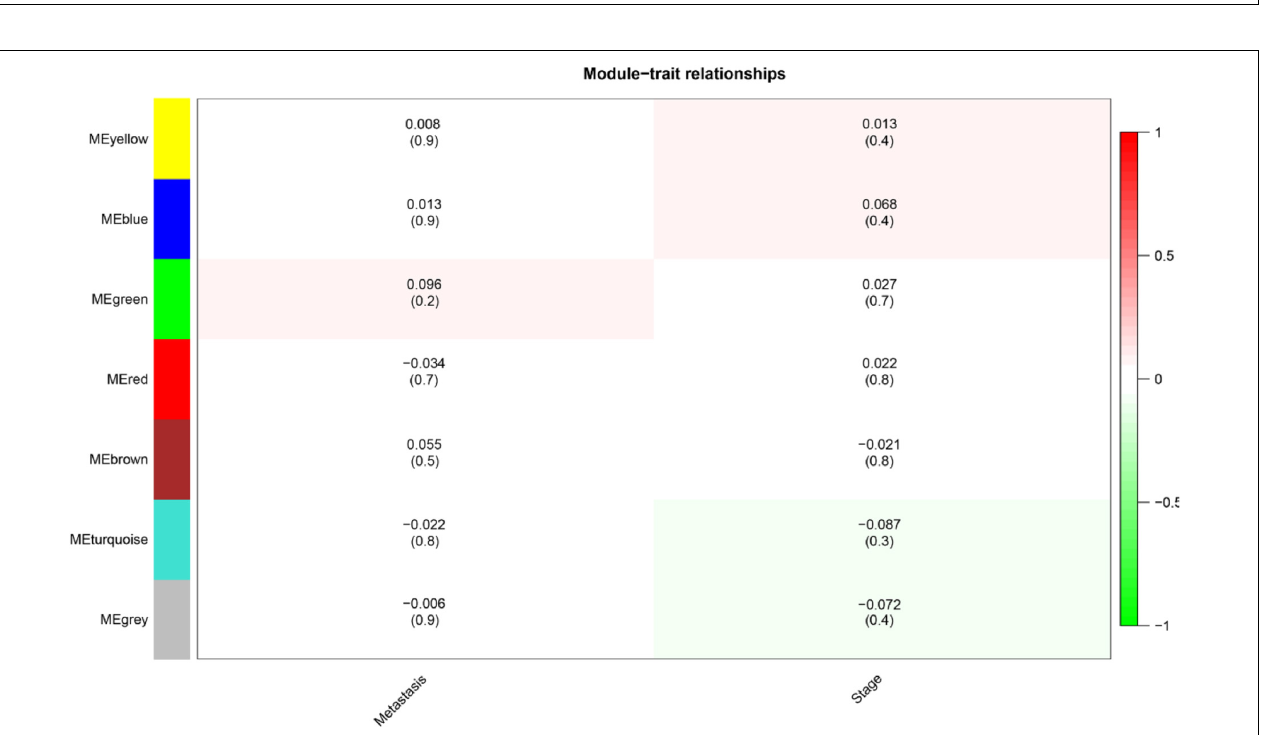
FIGURE 6 | Heat map of the correlation between module eigengenes and clinical subtypes (metastasis and stage) in colorectal adenocarcinoma. Each column showed the corresponding correlation and P -value.